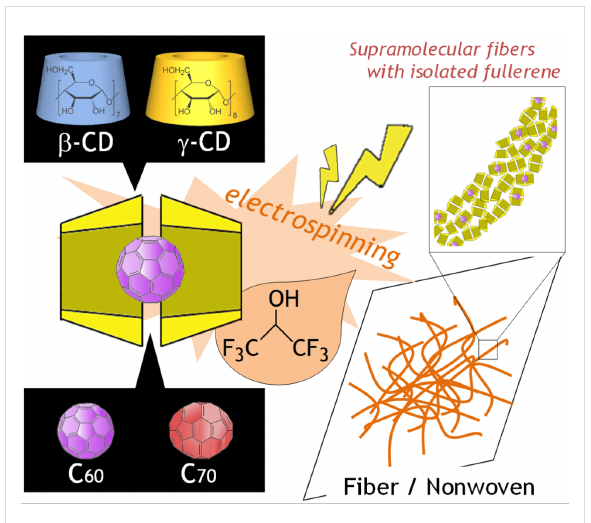
Figure 1: Schematic illustration of the fabrication of host–guest supra- molecular fibers with molecularly dispersed fullerenes by direct CD electrospinning. In this study, β -CD or γ -CD is used as a host and C 60 or C 70 is used as a